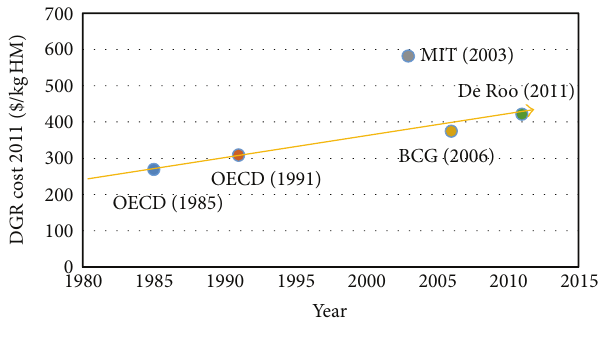
Figure 1: DGR costs trend [14].